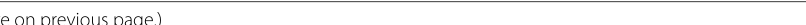
figure on previous Fig. 19 Summary of all mission data recorded on December 20, 2017. The top four panels show the temporal variation in the plasma wave power spectra: a the electric field power spectra at 10 kHz–10 MHz as recorded by the PWE high‑frequency analyzer (HFA), b the electric field and c the magnetic field power spectra at 10 Hz–20 kHz recorded by the PWE onboard frequency analyzer, and d the electric field power spectra at DC‑200 Hz recorded by the electric field detector. The next six panels show the temporal variation in the particle energy spectra of e 400 keV– 20 MeV electrons as recorded by the XEP, f 70 keV–1 MeV particles as recorded in the high‑energy particle experiments, g 10–80 keV electrons as recorded by the MEP‑e, h 19 eV–19 keV electrons as recorded by the LEP‑e, i 10–180 keV/q ions as recorded by the MEP‑i, and j 10 eV/q–25 keV/q ions as recorded by the LEP‑i. The bottom panel k shows the DC magnetic field recorded in the MGF experiments. The white blanks in panels a – j represent no or insufficient data or observations or observations made in a mode other than the observation mode. For example, during the long blanks shown in the ion measurements in ( i ) and ( j ), the ion analyzers were in TOF mode to conduct high‑resolution ion composition